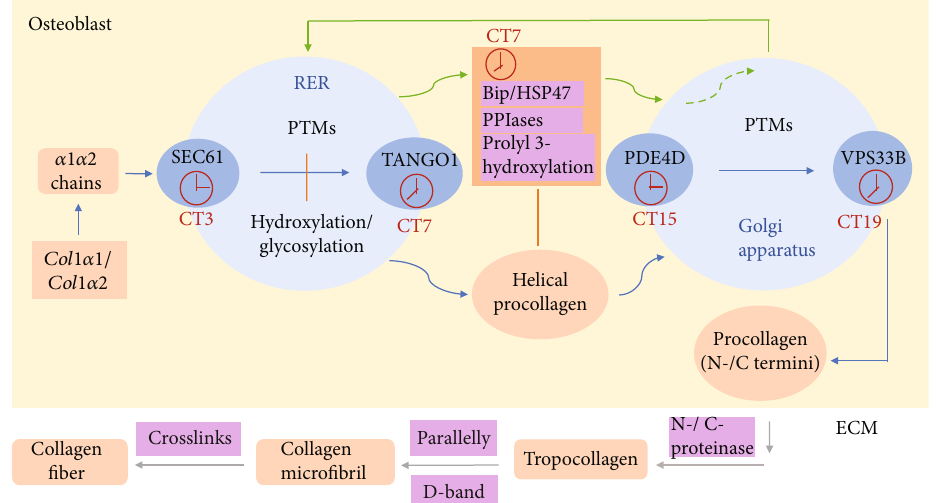
Figure 1: The rhythmic formation process of collagen. For the formation of collagen, Col1 α 1 and Col1 α 2 genes code α 1 and α 2 polypeptide chains severally. In the RER and Golgi apparatus, polypeptide chains fold into helical procollagen through posttranslational modi fi cations, including hydroxylation and glycosylation. And molecular chaperones in this process like BiP, HSP47, PPIases, and prolyl 3-hydroxylation are responsible for the transport and correct conformation [6, 28]. What is more, the proteins for regulating collagen transport like SEC61, TANGO1, PDE4D, VPS33B, and BiP are under the control of circadian rhythms with di ff erent oscillations. When procollagen transports outside osteoblasts to form tropocollagen, its N- and C-termini are hydrolyzed [16, 18]. Tropocollagen deposits side by side and orients parallelly in one fi bril but staggers with each other as the D -band. Eventually, multiple fi brils constitute collagen fi bers with cross-links [19]. RER: rough endoplasmic reticulum; PTMs: posttranslational modi fi cations; PPIases: peptidyl-prolyl cis - trans isomerases; ECM: extracellular